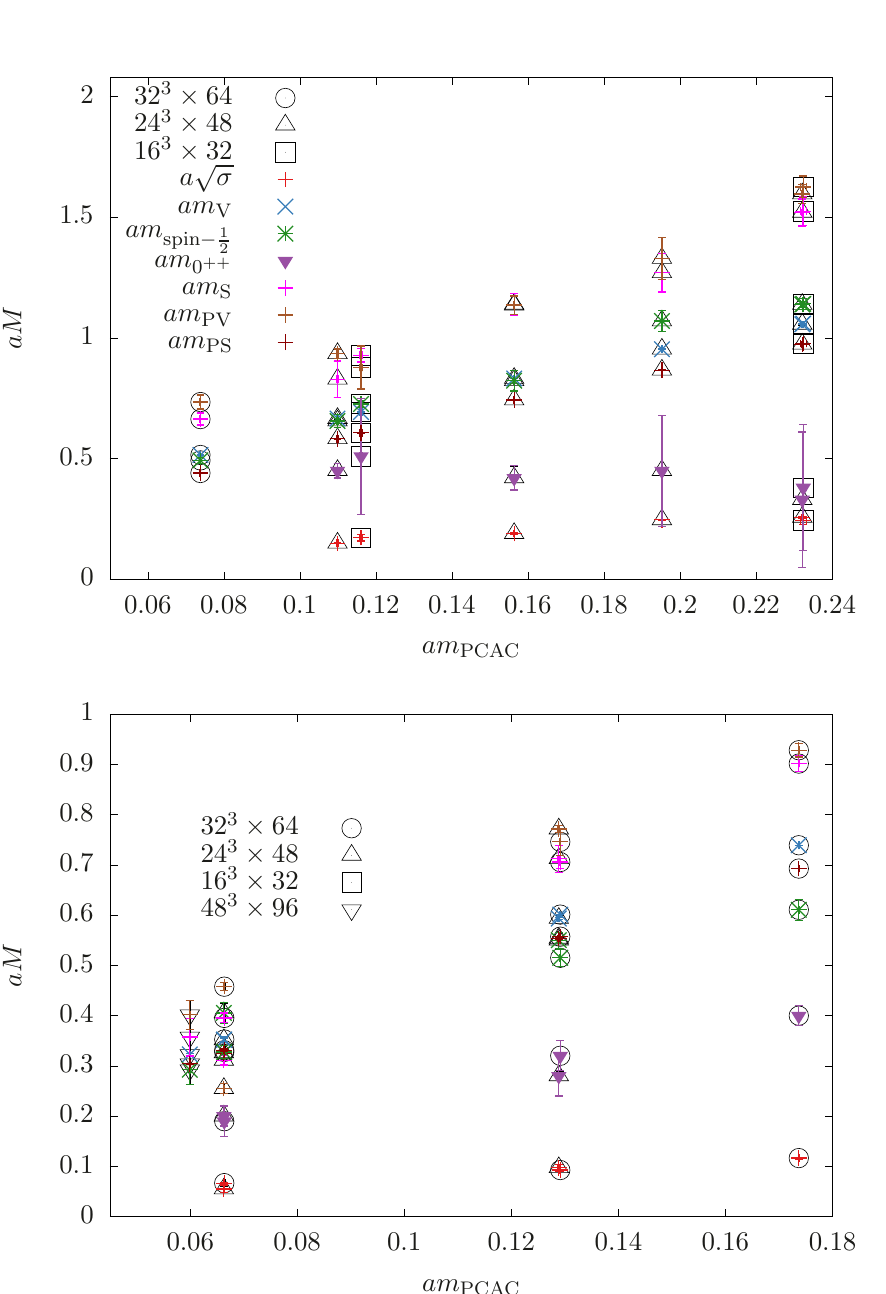
Figure 4 . Particle masses and